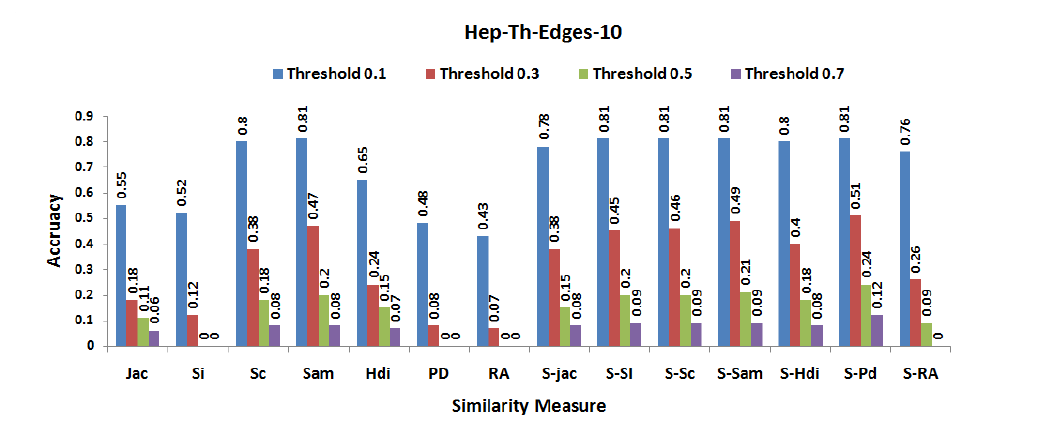
Figure 11. Prediction Results using HepTh Dataset with 5% Edges